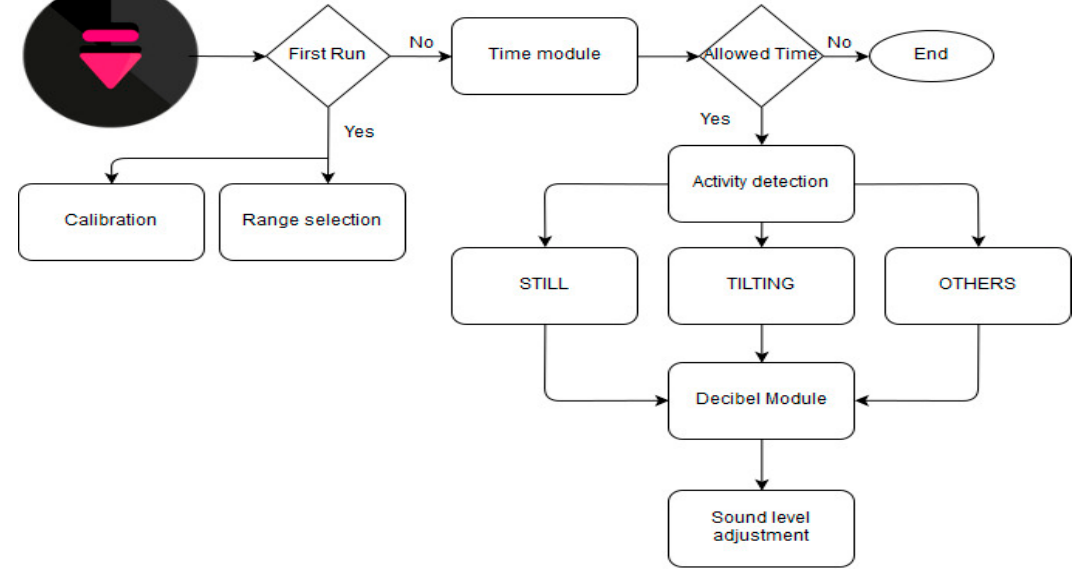
Figure 2. Proposed framework for automatic volume control.